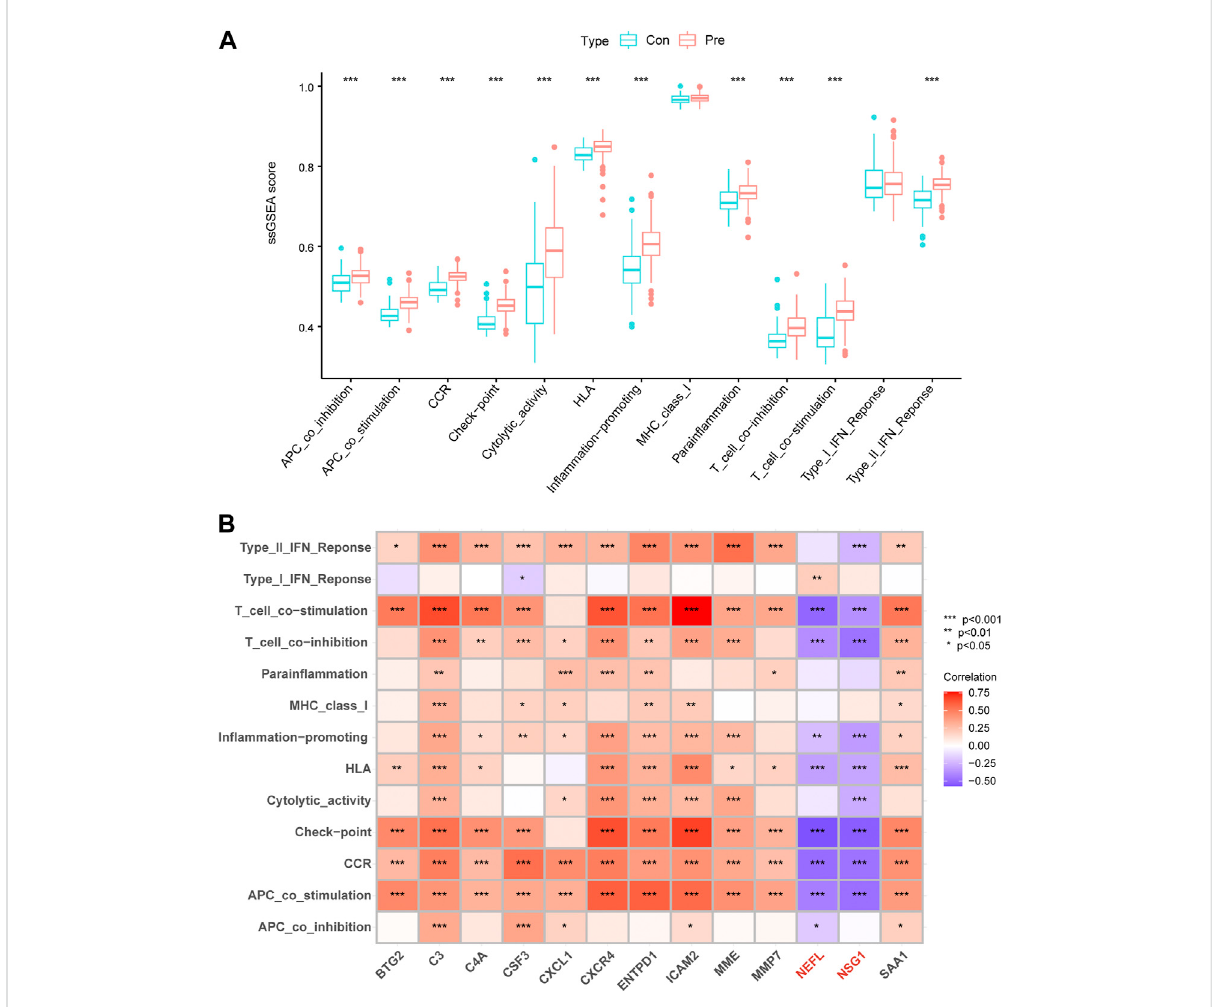
FIGURE 7 Immune functions differences and correlations. (A) Box plots ofthe 14immunefunction differencesbetweencontrol and periodontitis groups. (B) Correlation matrix of 13 key biomarkers and immune functions. * p < 0.05, ** p < 0.01, *** p <